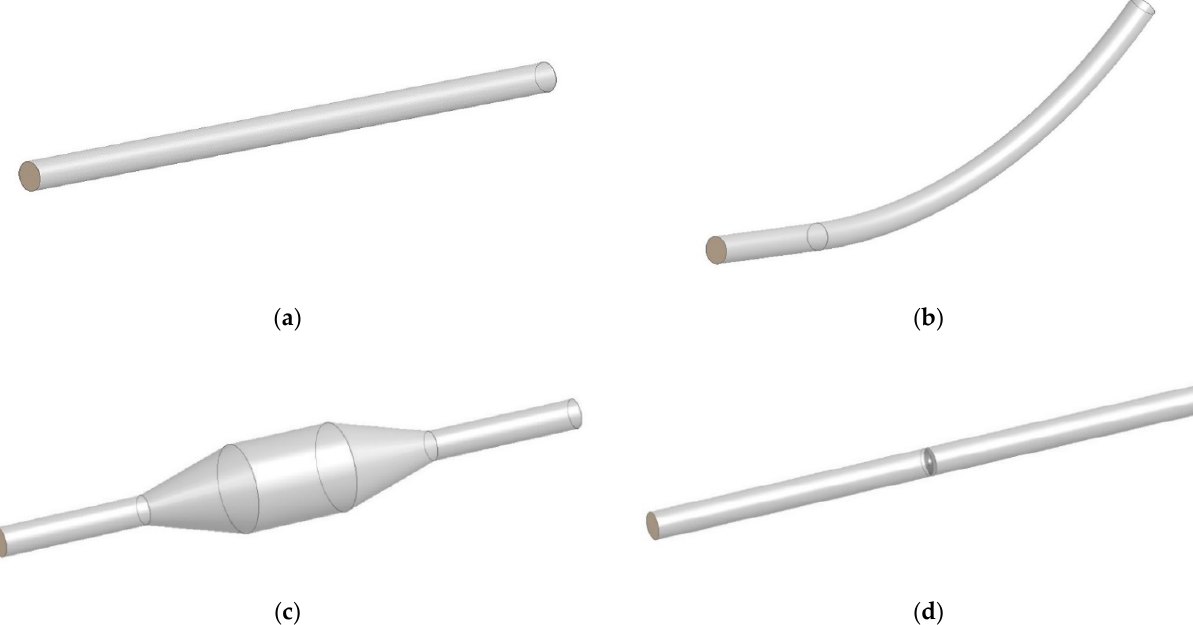
Figure 3. Four shapes of the subject of analysis: ( a ) straight pipe, same shape as the experiment; ( b ) bent pipe; ( c ) tapered pipe, shape of the expansion duct of SCR; and ( d ) an orifice installed in the center of the pipe.